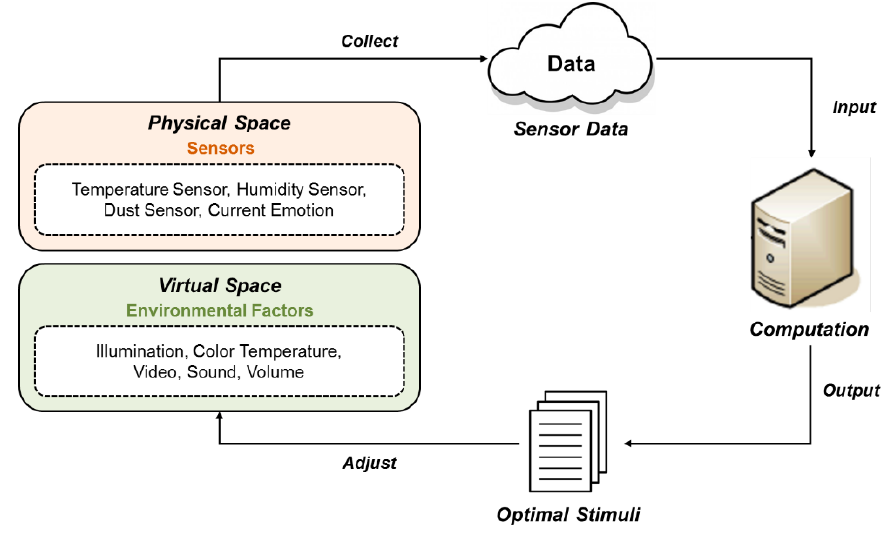
Figure 2. Overview of the proposed system.